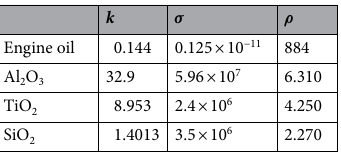
Table 1. The investigational values of Al 2 O 3 , SiO 2 , TiO 2 and engine oil 40 .